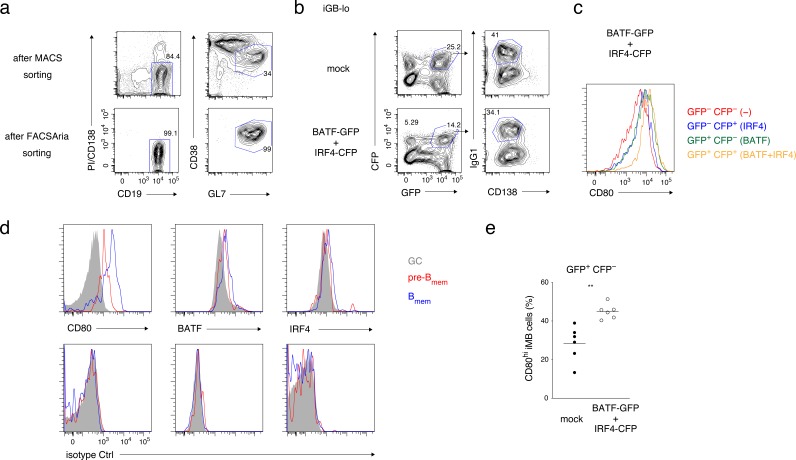
Supplementary data for Figure 7.(a) GC B cells magnetically enriched from splenocytes of the mice immunized 1 week previously (top) and further purified by fluorescence-activated cell sorting (FACS) sorting (bottom) were used for the analyses in Figure 7a. (b) Representative FCM data of iGB-lo cells on day 5 of the culture shown in Figure 7h. (c) The expression of CD80 on the indicated populations of IgG1+ iGB-lo cells shown in (b). (d) A representative FCM data for the analyses in Figure 7g. Cells were stained extra- (CD80) or intra-cellularly (BATF, IRF4) with antibodies against the indicated proteins (top) or with isotype-matched control antibodies (bottom). (e) The frequency of CD80hi Bmem cells in GFP+ CFP− fractions of iMB cells, as defined in the second panels from the left in Figure 7i, and in the experiment in Figure 7h–j. Legend for Supplementary file 1.